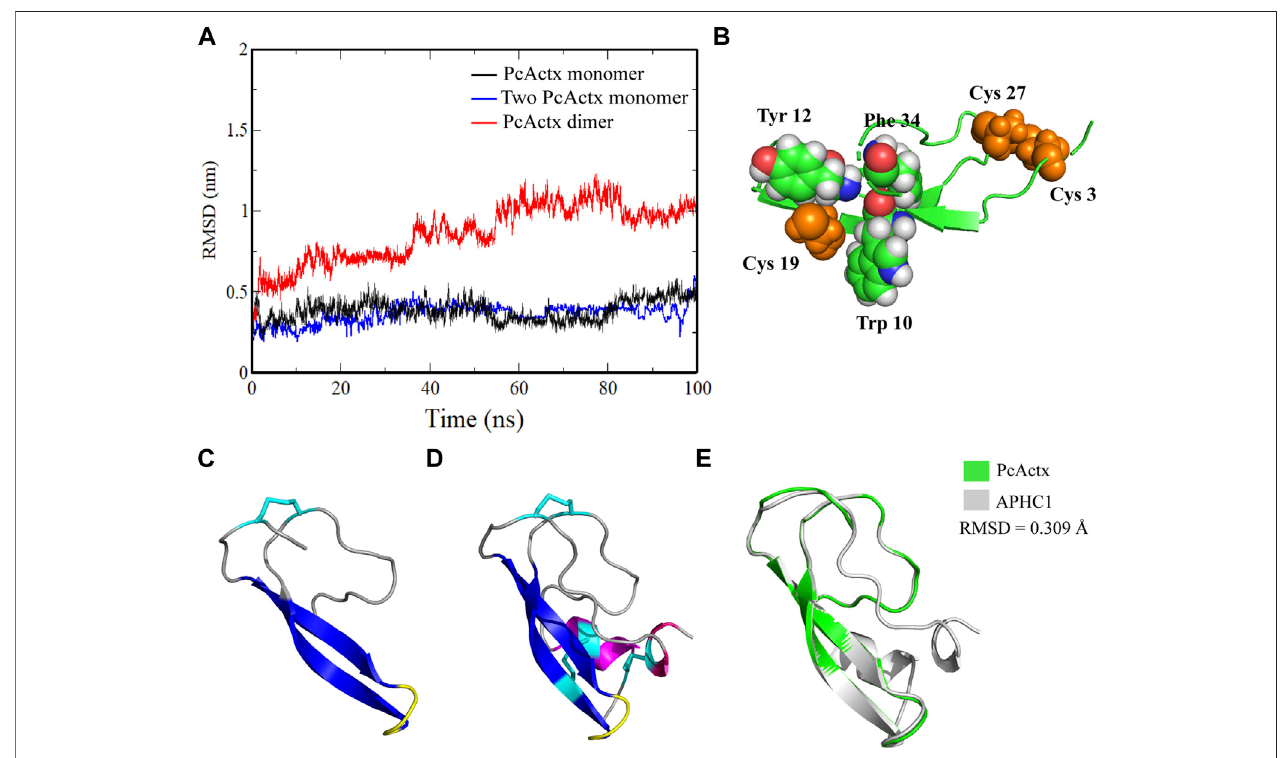
FIGURE 2 | MD simulation and structure comparison. (A) . MD simulation of PcActx peptide monomer and dimmer. (B) . Spatial structure of Cys 19 of PcActx peptide. Cys residues are shown as spheres in orange. Trp10, Tyr 12 and Phe 34 residues are shown as spheres in green. Other molecules are shown as cartoons in green. (C,D). HomologymodelstructureofPcActx (C) andAPHC1 (D) peptide.Moleculesareshownascartoonsandcoloredbasedonthesecondarystructure: α -helix in purple, β -sheet in blue, β -turn in yellow, coil in gray, and disul fi de bond in cyan. (E). Structure overlap of PcActx and APHC1. The structure of PcActx peptide is shown in green, and the structure of APHC1 peptide is shown in